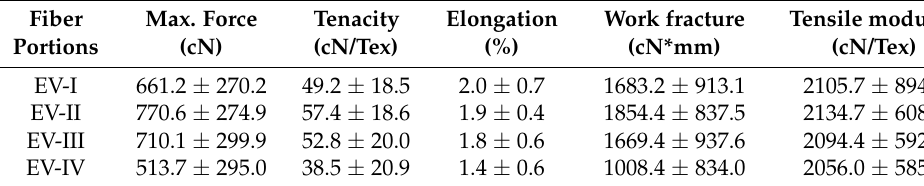
Table 2. The mechanical properties of Enset fiber.